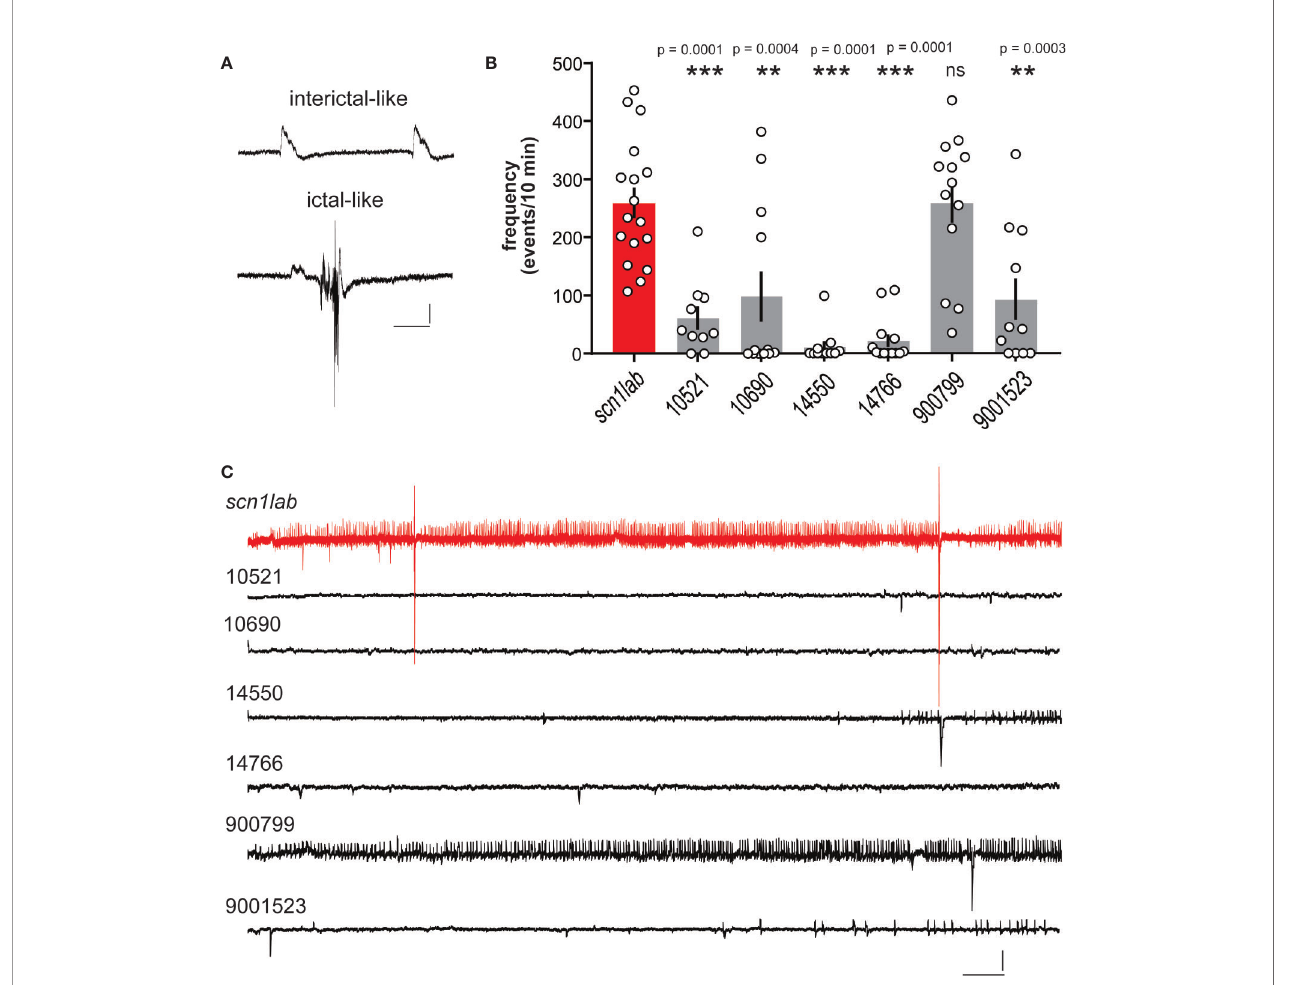
FIGURE 3 | Electrophysiological assay for compounds identi fi ed in the locomotion-based screening assay. (A) Local fi eld potential (LFP) recordings were obtained with an glass micro-electrode placed under visual guidance in the midbrain of agar-immobilized scn1lab larvae that had previously showed reduced seizure-like behavior in the locomotion assay. Representative examples of events classi fi ed as interictal- or ictal-like are shown. Scale bars: 1 mV, 0.5 s, (B) Bar graphs show the frequency of epileptiform events in a 10 min recording epoch for scn1lab larvae exposed to DMSO vehicle (scn1lab mutants; n = 17), JWH 018 N-(5-chloropentyl) analog (compound #10521; n = 10), JWH 018 N-(2-methylbutyl) isomer (compound #10690; n = 12), 5- fl uoro PB-22 5-hydroxyisoquinoline isomer (compound #14550; n = 11), 5- fl uoro ADBICA (compound #14766; n = 13), JWH 018 adamantyl analog (compound #9000799; n = 13), and AB-FUBINACA 3- fl uorobenzyl isomer (compound #90001523; n = 11). Mean ± SEM and individual data points are shown. One-way analysis of variance with Dunnet's multiple comparisons was used to test for signi fi cance. **p < 0.001; *** p < 0.0001. (C) Representative electrophysiology traces (10 min) are shown for SC compounds 10521, 10690, 14550, 14766, 9000799, and 900015323 compared to an scn1lab mutant zebra fi sh (red). Scale bars: 1 mV, 10